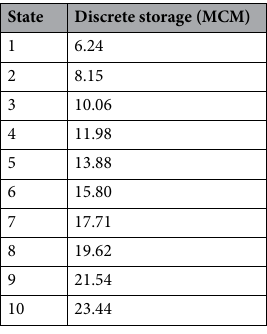
Table 1. Discrete storage, d